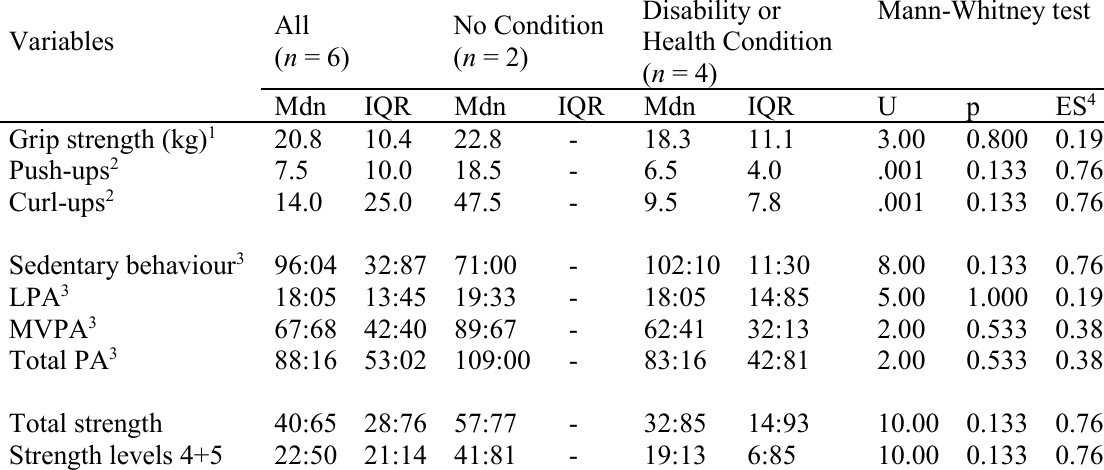
Table 2. Median (Mdn) scores, interquartile range (IQR) and Mann-Whitney test (U) results comparing muscular strength and time spent in physical activity and strength activities of vaulters with and without a disability/health